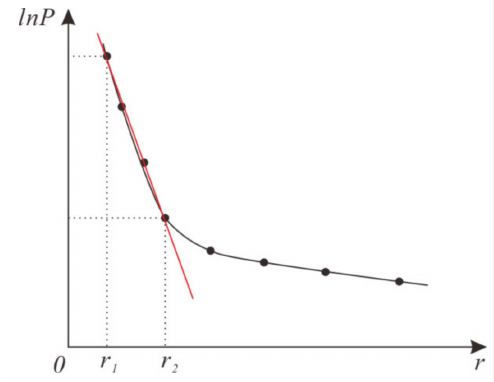
Figure A4. Radial logarithmic power spectrum.